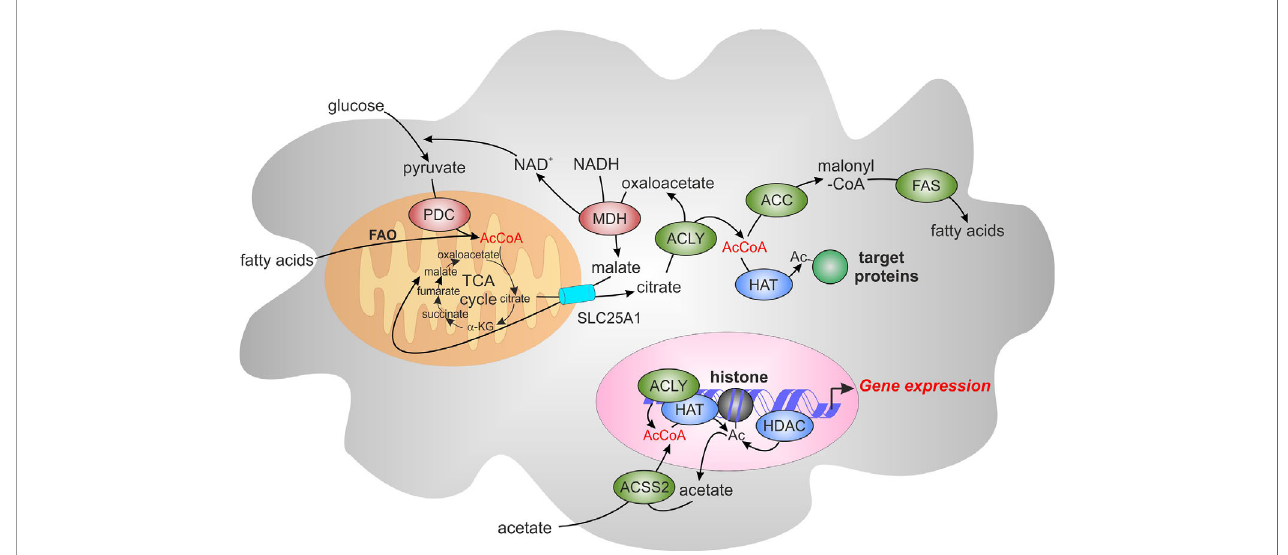
FIGURE 1 | The role of acetyl-CoA and ATP-citrate lyase (ACLY) in de novo lipogenesis and epigenetic modi fi cations. Acetyl-CoA (AcCoA) is predominantly produced in mitochondria through oxidation of glycolysis-derived pyruvate by pyruvate dehydrogenase complex (PDC) and through fatty acid oxidation (FAO). AcCoA condensation with oxaloacetate in the tricarboxylic acid cycle (TCA) produces citrate, which can be exported from mitochondria through the mitochondrial citrate carrier, SLC25A1. Citrate is converted by ACLY localized in the cytosol and the nucleus to AcCoA and oxaloacetate. Oxaloacetate is reduced to malate by cytosolic malate dehydrogenase (MDH), providing the source of NAD + to support glycolysis. Malate is imported back into the mitochondria through SLC25A1, completing the citrate-malate shuttle. Cytosolic Acetyl-CoA can be carboxylated to malonyl-CoA by acetyl-CoA carboxylase (ACC). Malonyl-CoA provides a substrate for fatty acid synthase (FAS) for de novo fatty acid synthesis. Acetyl-CoA can also be as a substrate of acetylation of cytosolic and nuclear proteins. These reactions are catalyzed by histone acetyltransferases (HATs) whereas histone deacetylases (HDACs) mediate the removal of acetyl group. Acyl-CoA synthetase short-chain family member 2 (ACSS2) offers an alternative source of cytosolic or nuclear acetyl-CoA by employing acetate imported from extracellular sources or recycling acetate from histone deacetylation reactions. a -KG, a